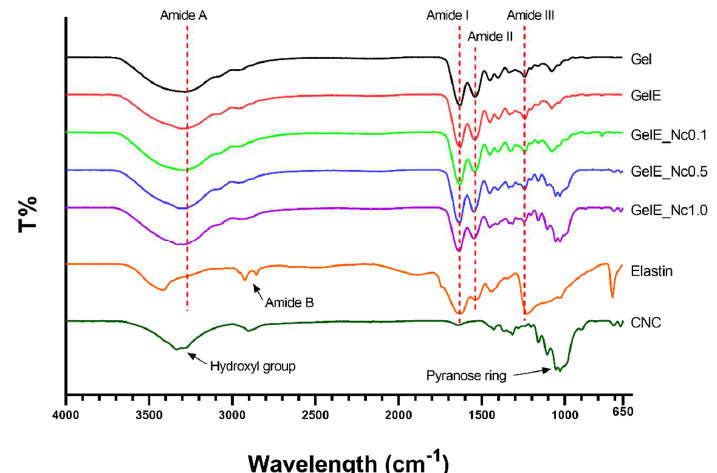
Figure 3. FTIR spectrometry for determining any chemical structure changes for each biomaterial used in the composite scaffolds. Gelatin, the base material, showed no changes in its functional group. Elastin and CNC showed chemical changes when incorporated into the composite scaffolds.